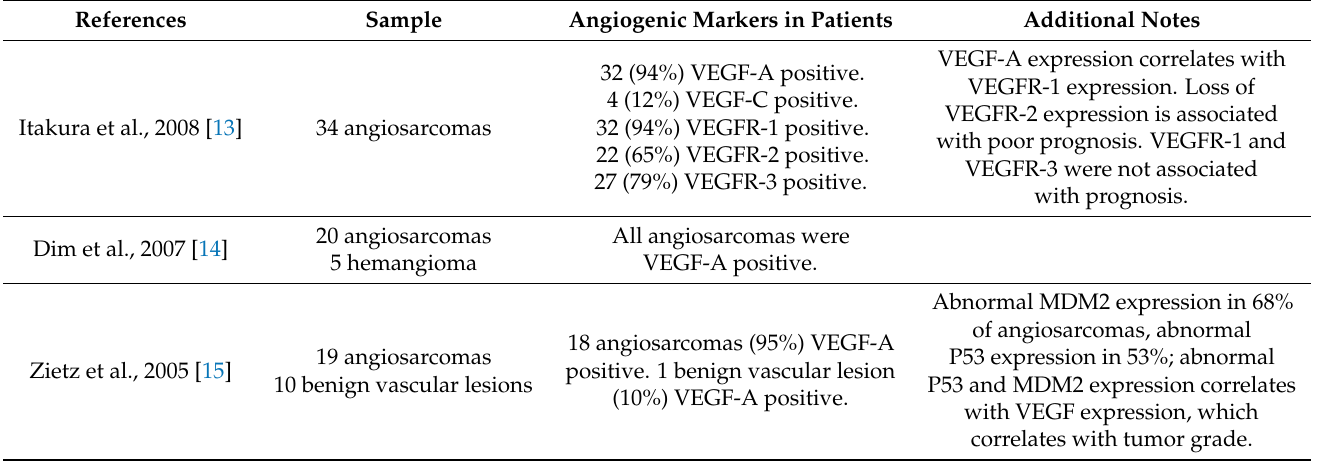
Table 1. Immunohistochemical reports of the principal markers of vascular endothelium growth found in patients with angiosarcoma and other pathologies related to their respective variability of